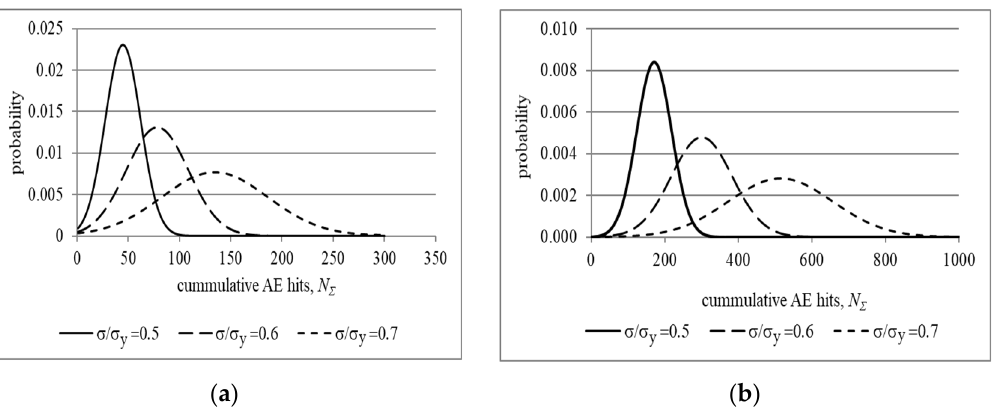
Figure 7. Probability density function N Σ for steels 09G2S ( a ) and 45 ( b ).